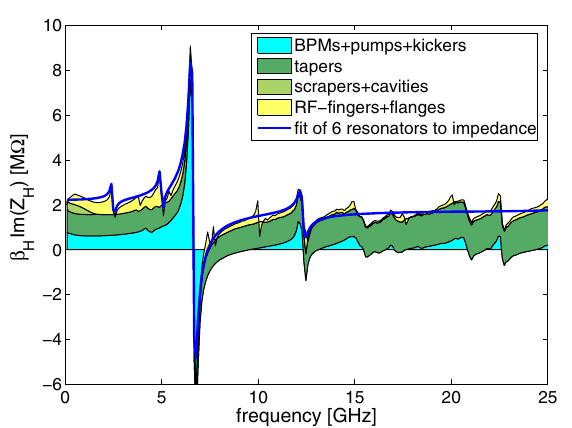
FIG. 14. (Color) Effective vertical and horizontal impedance budget weighted by the local (cid:1) -function. Only the dipolar component is taken into account in the effective